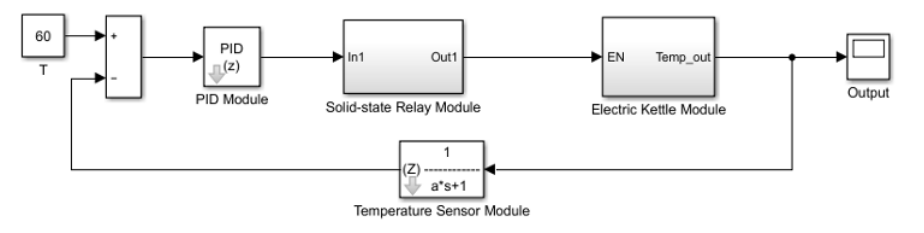
Fig. 2. The electric kettle temperature control model.